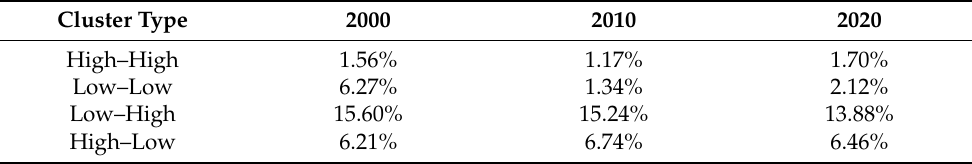
Table 2. Percentage of bivariate spatial autocorrelation cluster